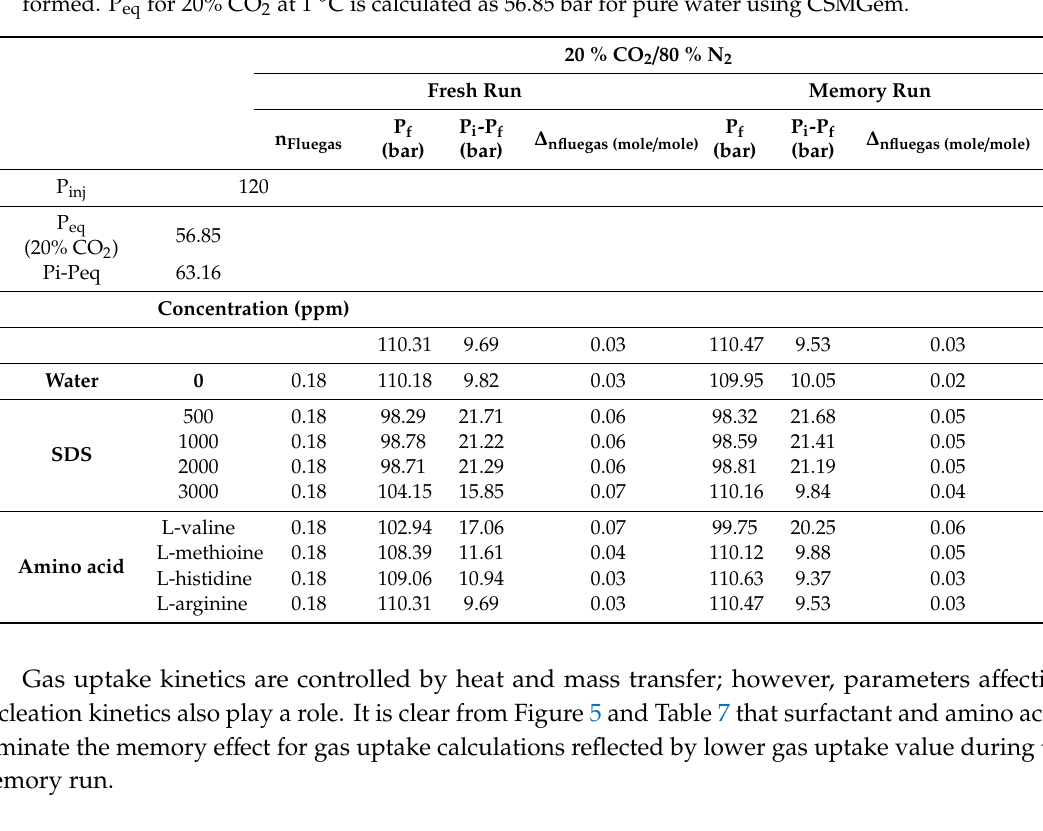
Table 7. Gas uptake calculations for 20% CO 2 in CO 2 / N 2 mixture for both fresh and memory runs.